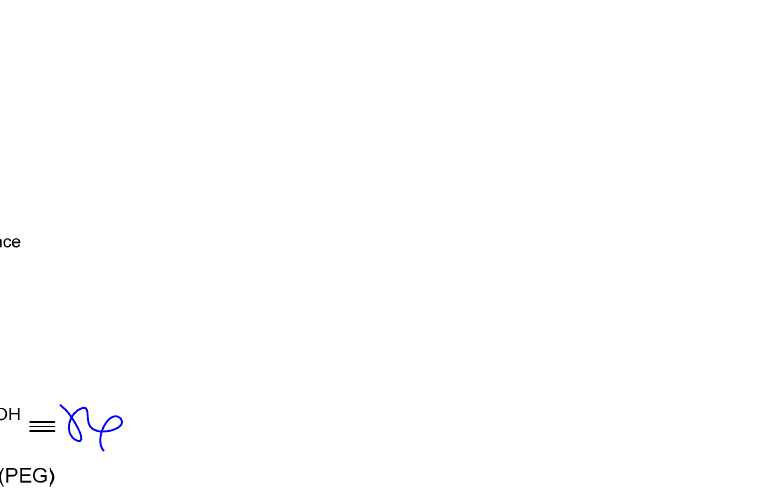
Figure 1. General structure of NIR-AZA fluorophores showing position of PEG attachments via blue coloured aryl ring and non-pegylated reference fluorophore 1a used in this study. Design of ( A ) mono and ( B ) dual substituted pegylated (blue line) NIR-AZA fluorophores (red rectangle).